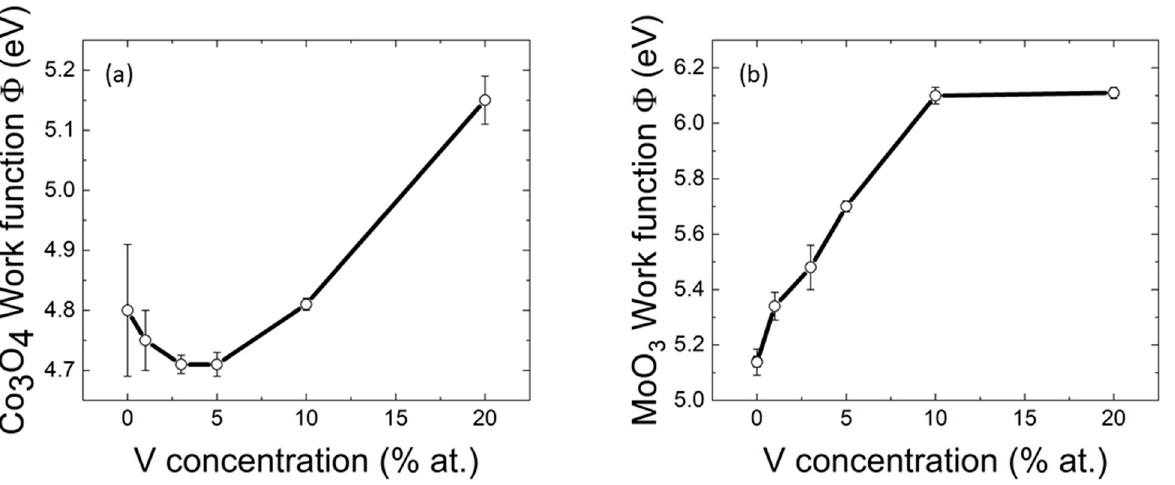
Figure 5. Work function values estimated through Kelvin probe microscopy analysis for the ( a ) Co 3 O 4 :V and ( b ) MoO 3 :V samples series.